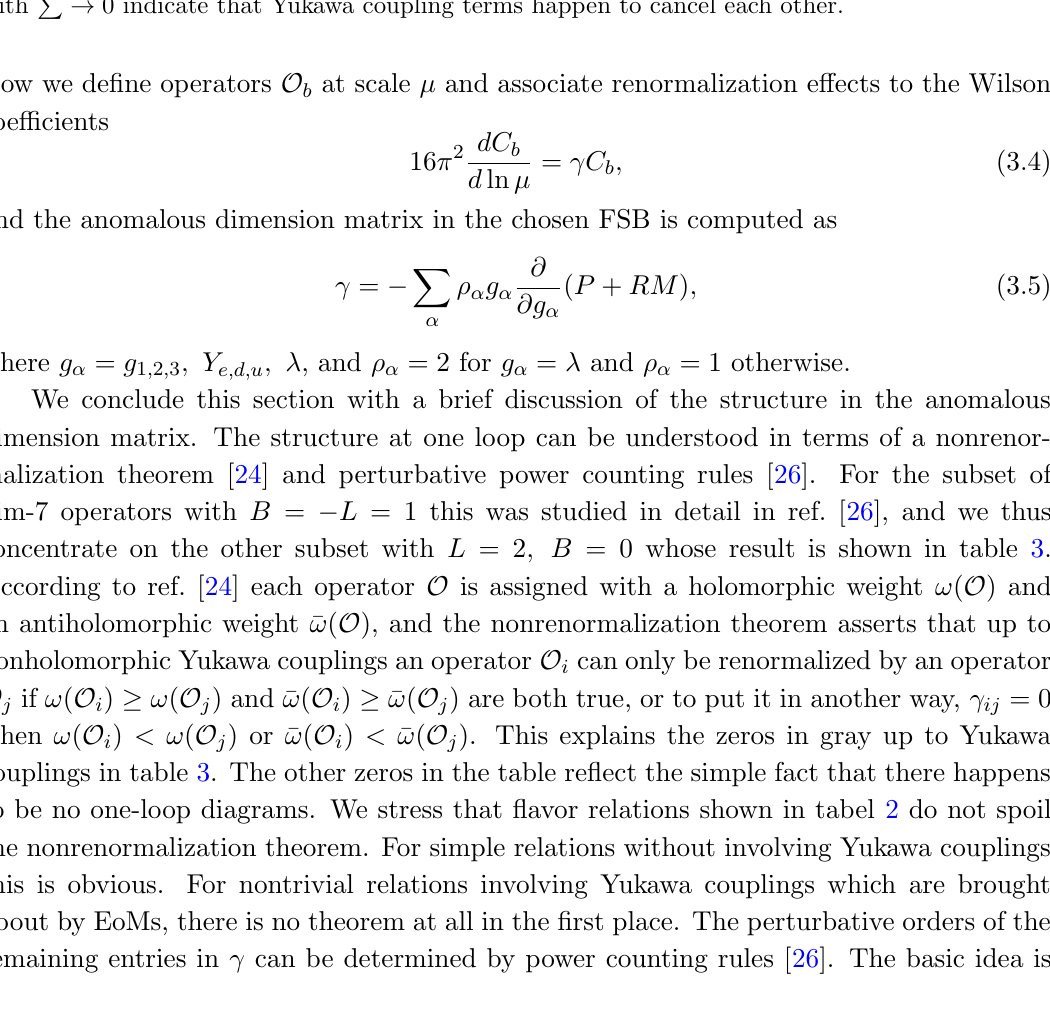
Table 3 . The structure and perturbative power counting of the anomalous dimension matrix (cid:13) ij for the subset of dim-7 operators with L = 2 ; B = 0. Also shown are holomorphic ( ! ) and antiholomorphic ((cid:22) ! ) weights and perturbative power counting ( (cid:31) ) of the operators. The entries with P ! 0 indicate that Yukawa coupling terms happen to cancel each